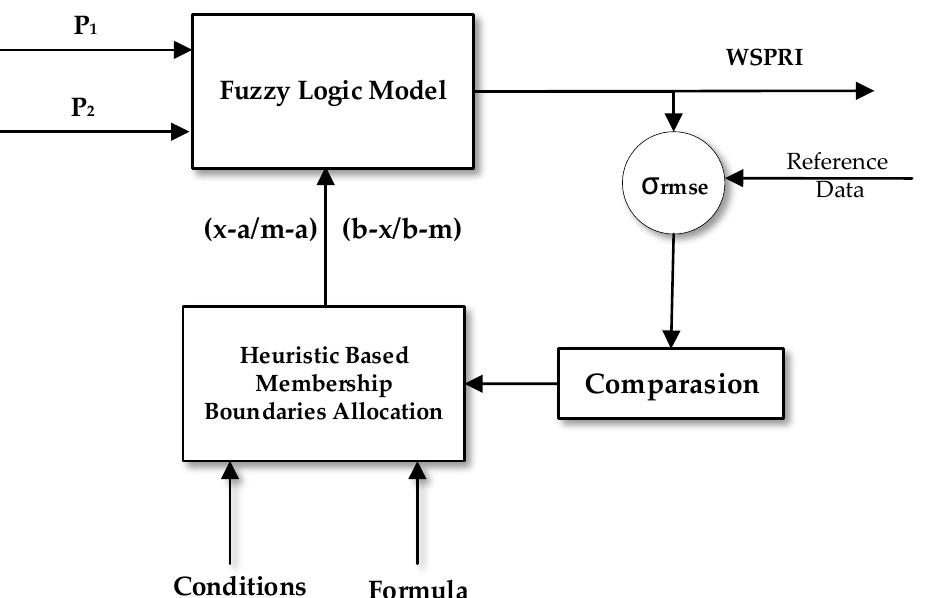
Figure 3. Heuristic-based membership functions (MFs) allocation scheme.